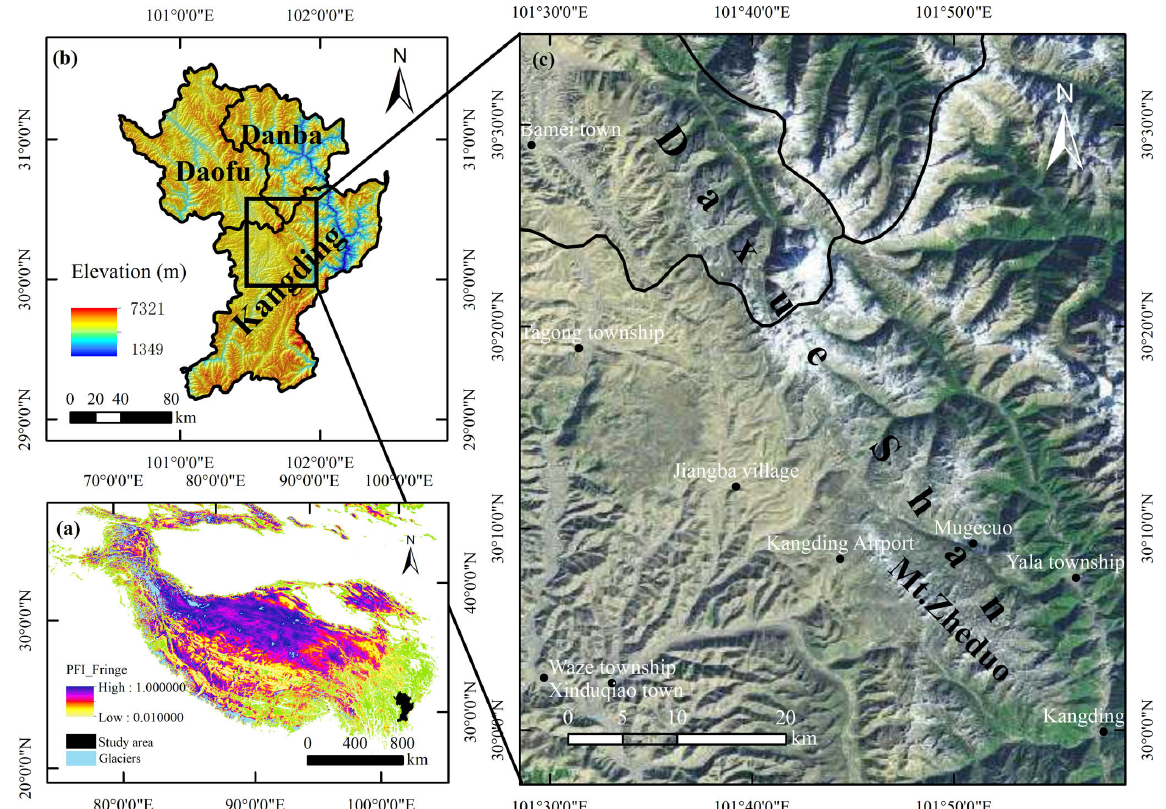
Figure 1. (a) The location of the study area in the permafrost zone of the TP. The Permafrost Zonation Index (PZI) or a corresponding map colour indicates to what degree permafrost exists only under the most favourable conditions (yellow) or nearly everywhere (blue); the map was produced using a temporal resolution of 30arcsec ( < 1km) on a WGS84 lat–long grid plotted in a projected coordinate system (Gruber, 2012). (b) The geographical and topographical maps of the study area based on a spatial resolution of 30m using ASTER GDEM V2 software, as shown in the WGS84 coordinate system. (c) Image of the study area. Map data: Google,